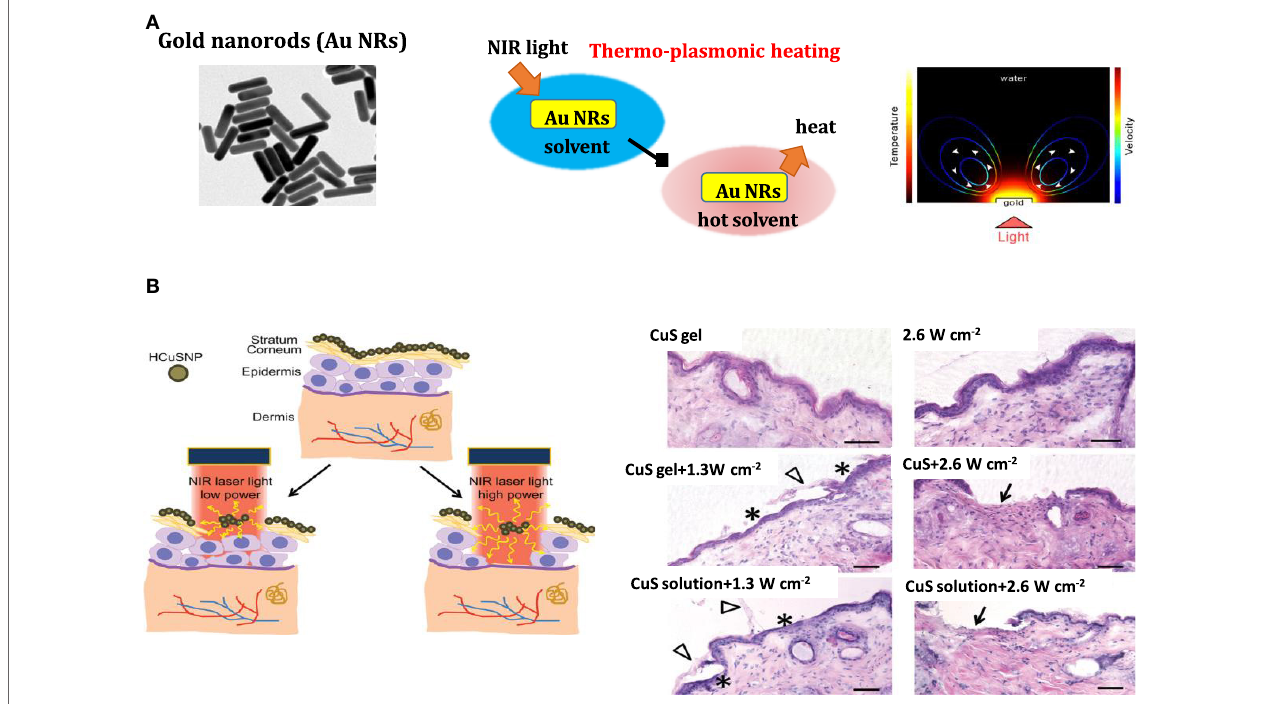
FigURe 4 | (A) Plasmonic heating: (left) TEM image of gold nanorods (Au NRs) (middle) effect of thermo-plasmonic heating on the temperature of the surrounding medium and (right) temperature map on Au NRs upon light illumination [reprint with permission from Baffou et al. (2013)]. (b) (left) Illustration of near-infrared (NIR) laser-triggered photothermal ablation of skin mediated by hollow copper sulfide (CuS) nanoparticles (NPs) and (right) histological images of skin section of nude mice treated with hollow CuS NP gel, pulsed laser (2.6 W cm − 2 ), hollow CuS NP gel + laser pulse (1.3 W cm − 2 ), hollow CuS NP gel + laser pulse (2.6 W cm − 2 ), hollow CuS NP solution + laser pulse (1.3 W cm − 2 ), and hollow CuS NP solution + laser pulse (2.6 W cm − 2 ); asterisks: epidermis without stratum corneum ; arrowheads: stratum corneum layers stripped from epidermis; arrows: dermis with removal of both stratum corneum and viable epidermis; scale bars: 50 µm [reprint with permission from Ramadan et al.